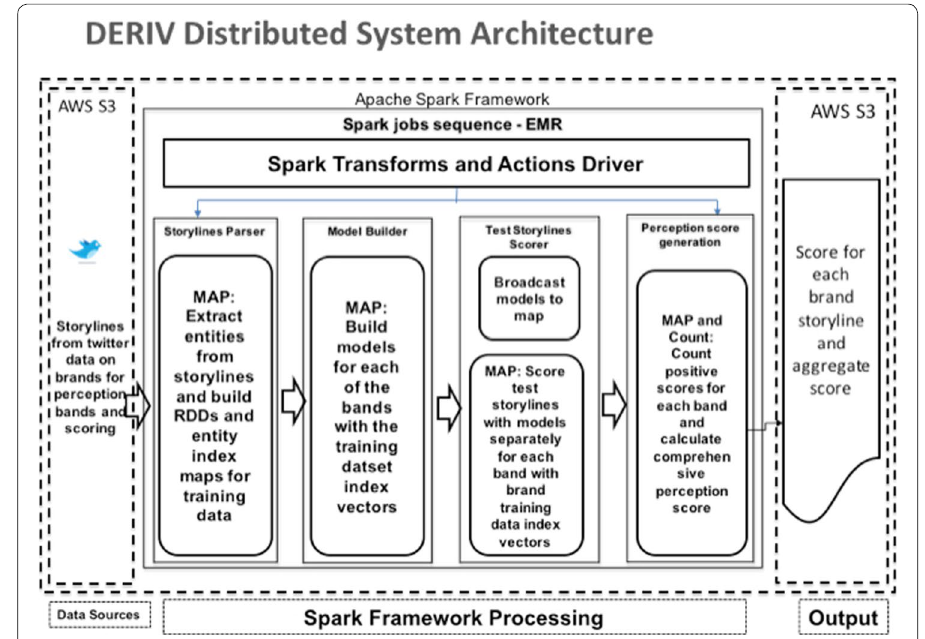
Fig. 3 DERIV brand perception calculation framework